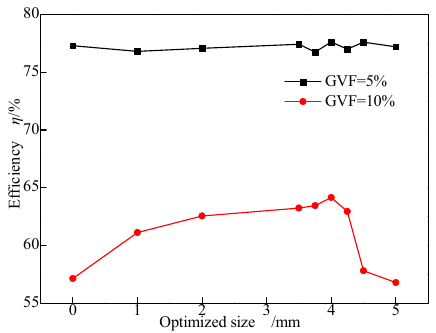
Figure 8. Efficiency curve of different optimized sizes.